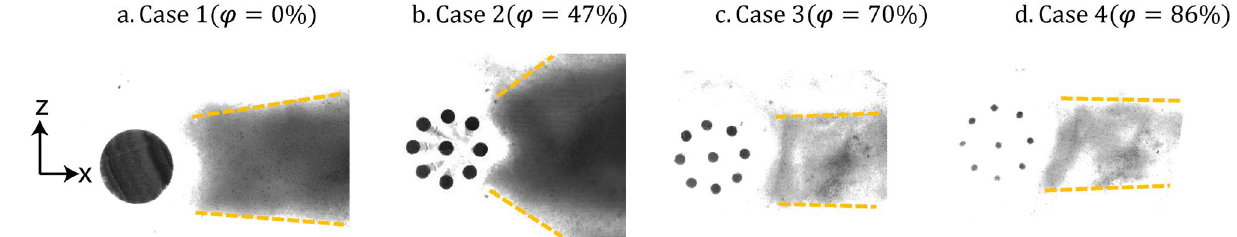
Figure 2. The sediments on the flume bed are indicated by the grayscale image of the sediment trajectories deposited on the flume bed. The flow was from left to right in the image. The black circles indicate the